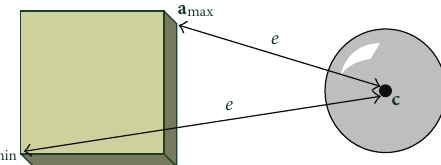
Figure 7: Principles of the intersection test between an OBB and a sphere.